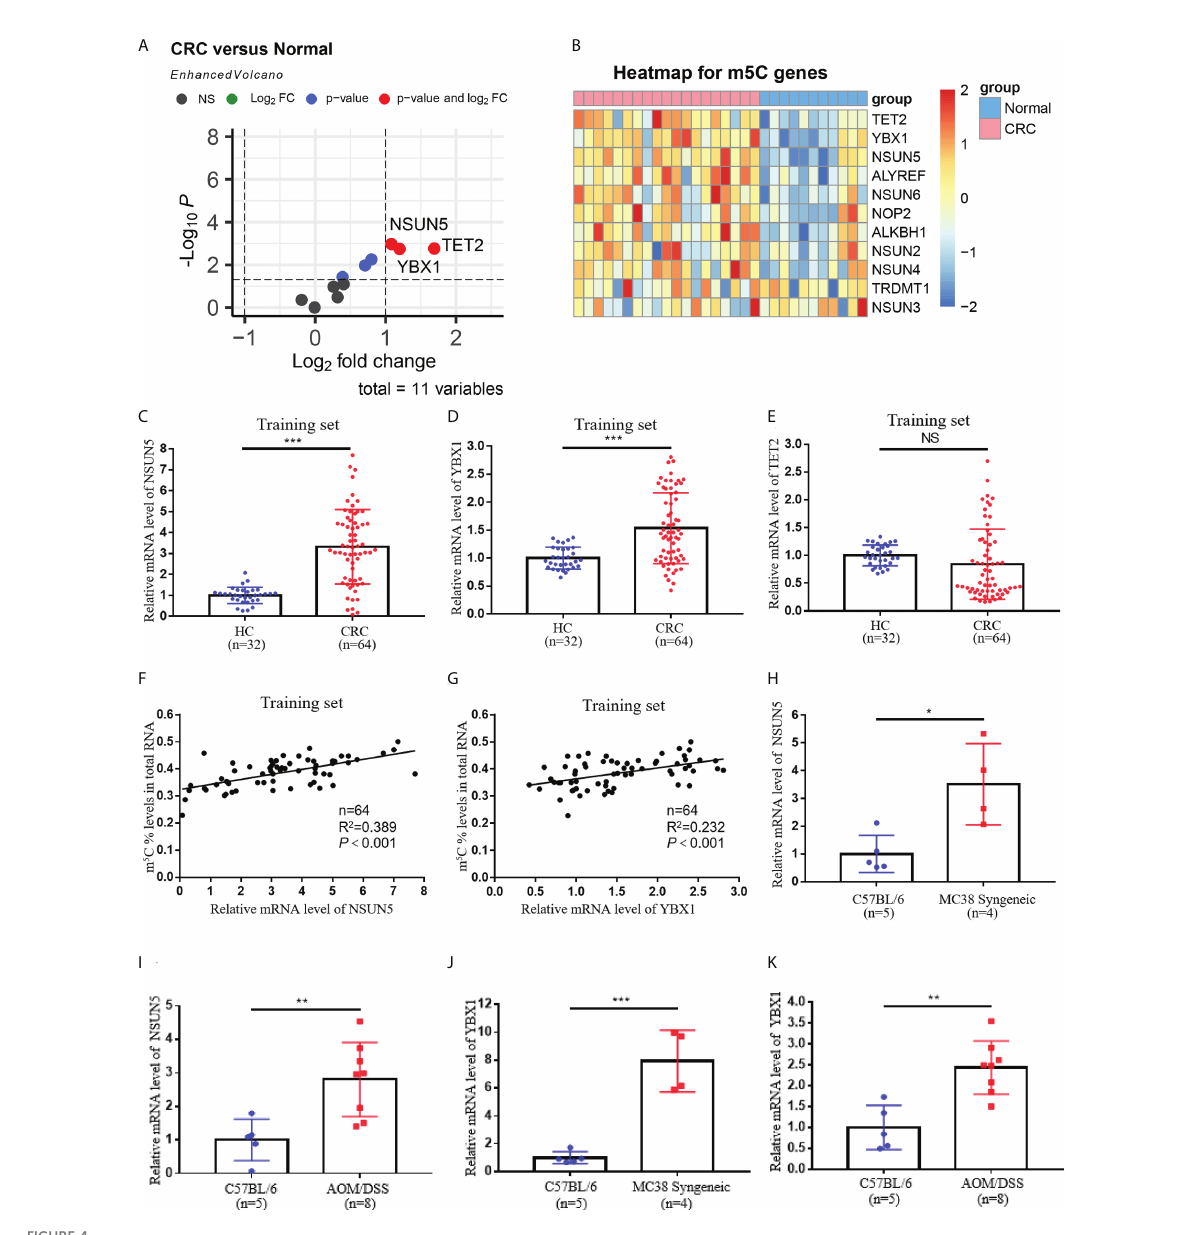
FIGURE 4 Expressions of m 5 C-modi fi ed regulators NSUN5 and YBX1 in peripheral blood immune cells of CRC. (A) Screening of key molecules associated with m 5 C modi fi cation in peripheral blood immune cells of CRC patients by limma differential analysis. (B) Heatmap of key molecules associated with m 5 C modi fi cation in blood immune cells of CRC patients. (C-E) qRT-PCR analysis of NSUN5 (C) , YBX1 (D) , and TET2 (E) mRNA expression levels in blood immune cells of HC and CRC patients in the training set. (F) Correlation between the levels of NSUN5 and m 5 C in blood immune cells of CRC patients in the training set. (G) Correlation between the levels of YBX1 and m 5 C in blood immune cells of CRC patients in the training set. (H, I) qRT-PCR analysis of NSUN5 mRNA expression levels in blood immune cells of MC38 Syngeneic mice (H) and AOM/DSS mice (I) . (J, K) qRT-PCR analysis of YBX1 mRNA expression levels in peripheral blood immune cells of MC38 Syngeneic mice (J) and AOM/DSS mice (K) . Data are shown as mean ± SD; * P < 0.05, ** P < 0.01, *** P <